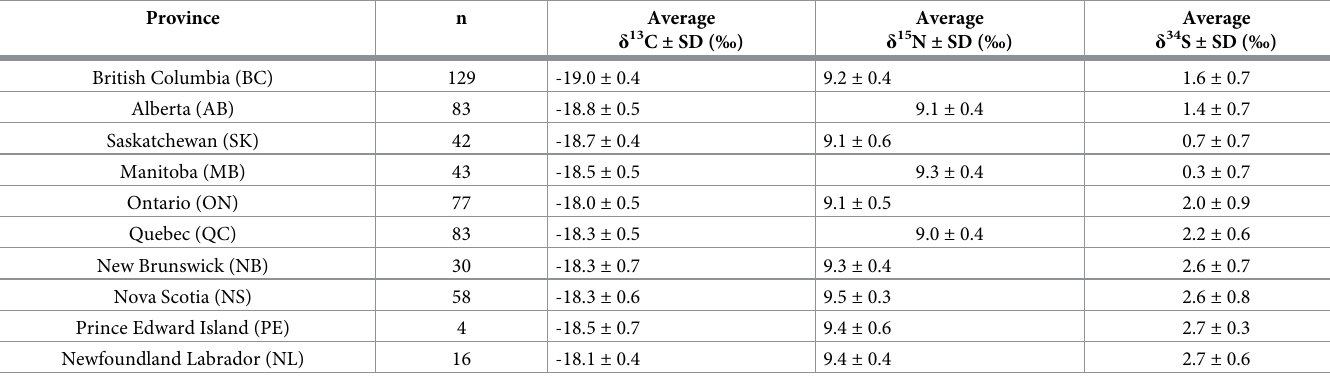
Table 5. δ 13 C hair , δ 15 N hair and δ 34 S hair values from participants residing in different provinces.